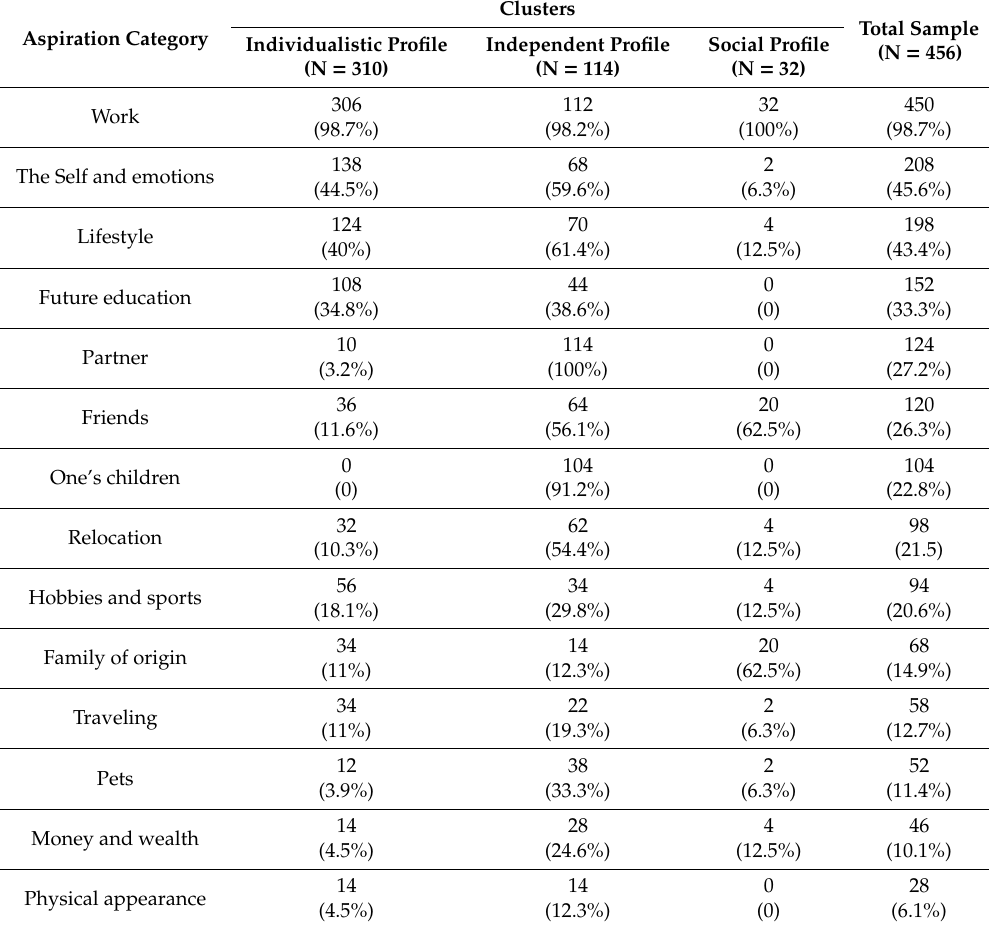
Table 2. The frequencies and percentages of the three clusters for each aspiration